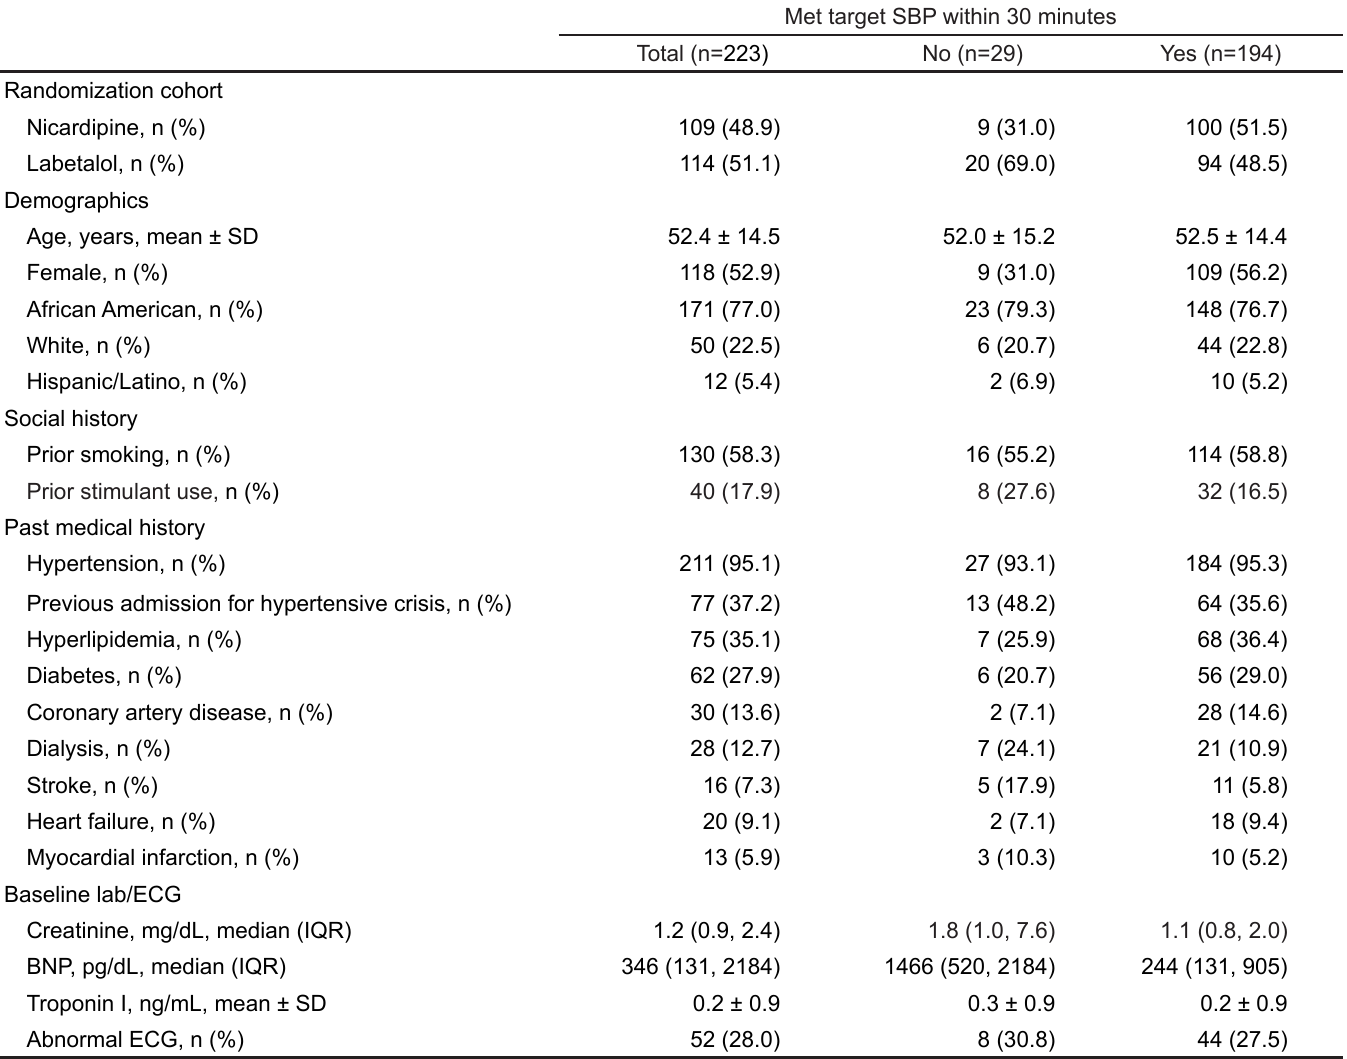
Table 1. Characteristics of patients by responder status.